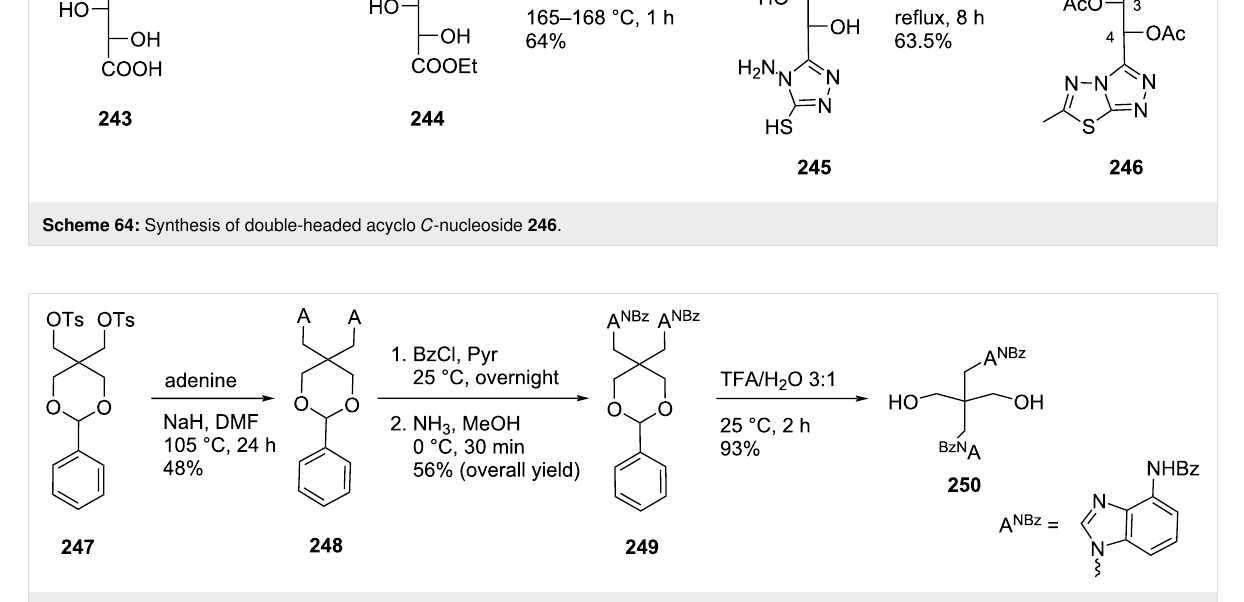
Scheme 65: Synthesis of acyclo double-headed nucleoside 250